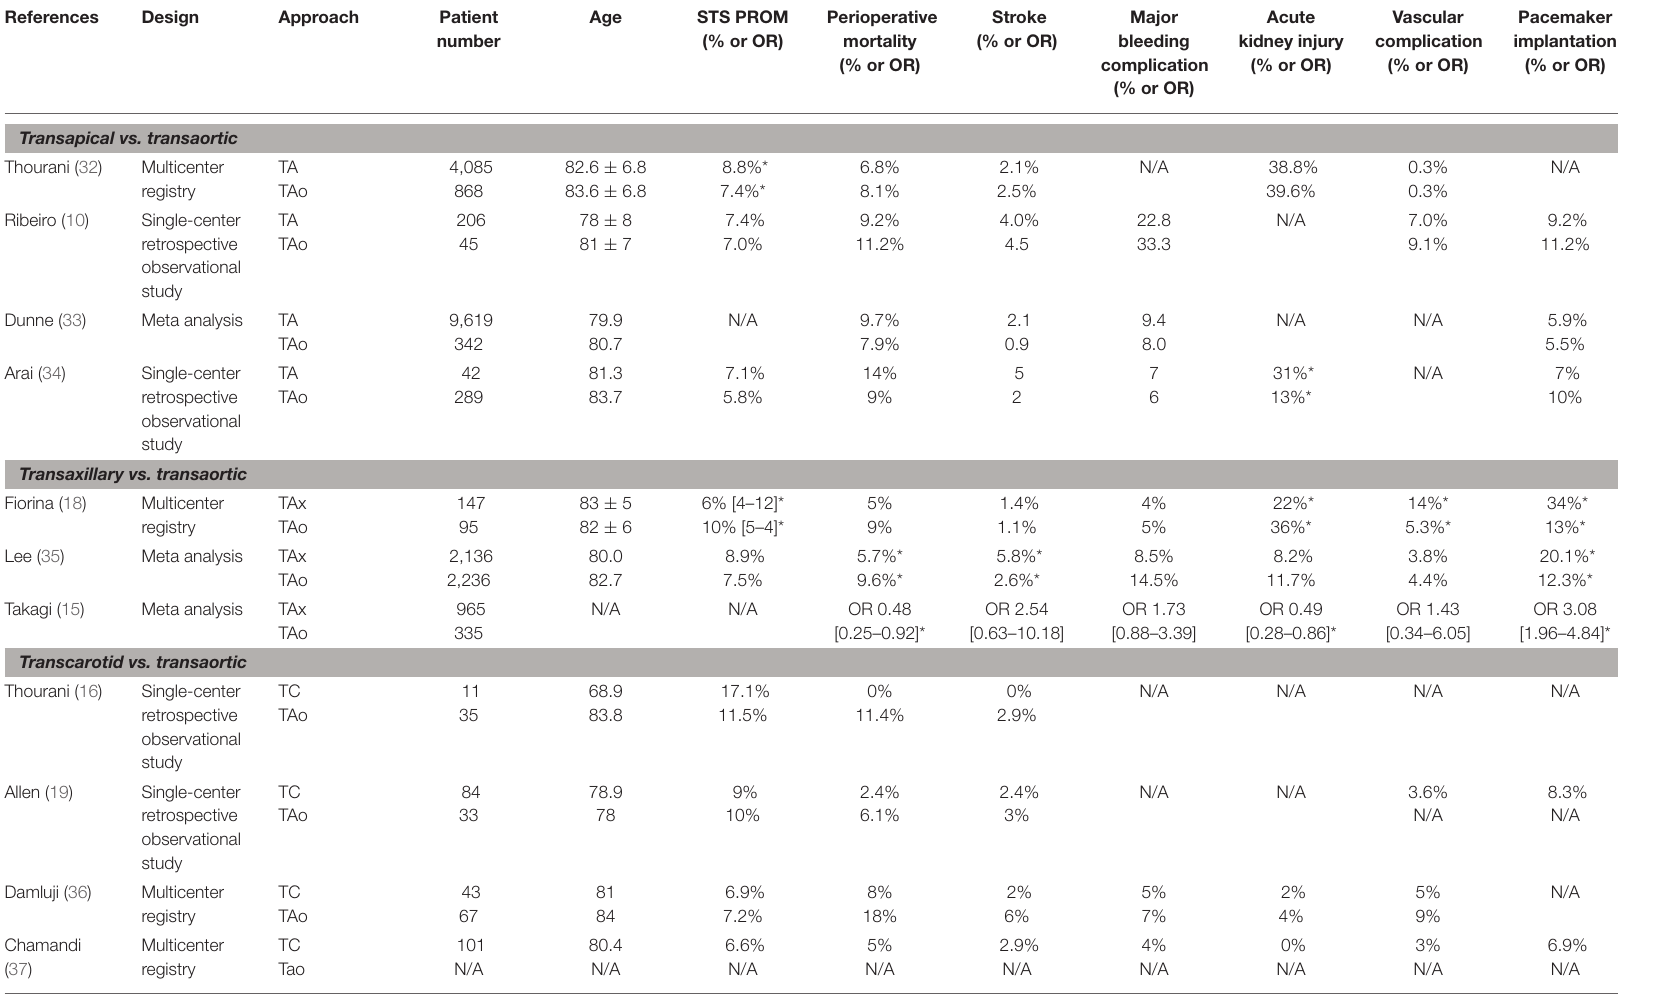
TABLE 1 | Overview of selected studies comparing transaortic with other alternative access